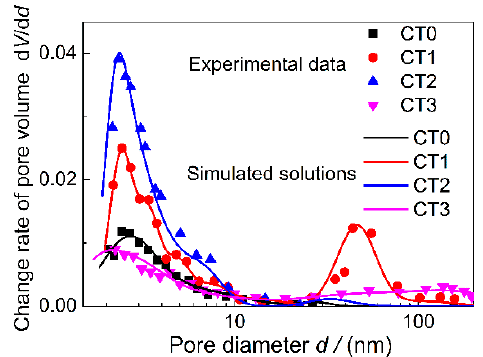
Figure 6. Comparison of the calculated results with the experimental data for pore structure Comparison of the calculated results with the experimental data for pore characteristics. structure